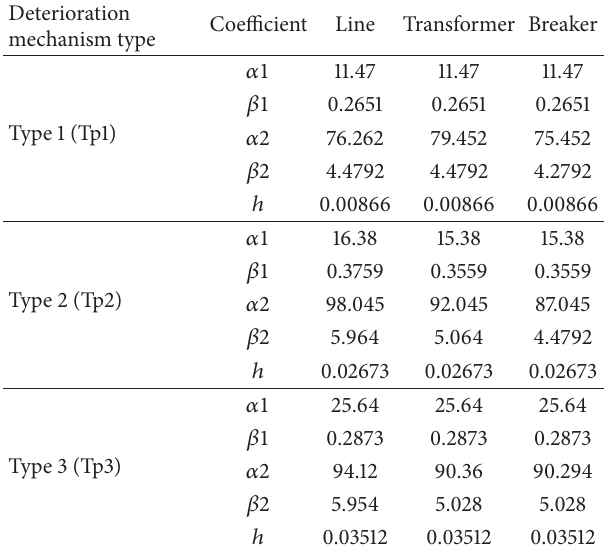
Table 1: Deterioration mechanisms data of 11kV feeder distribution system.